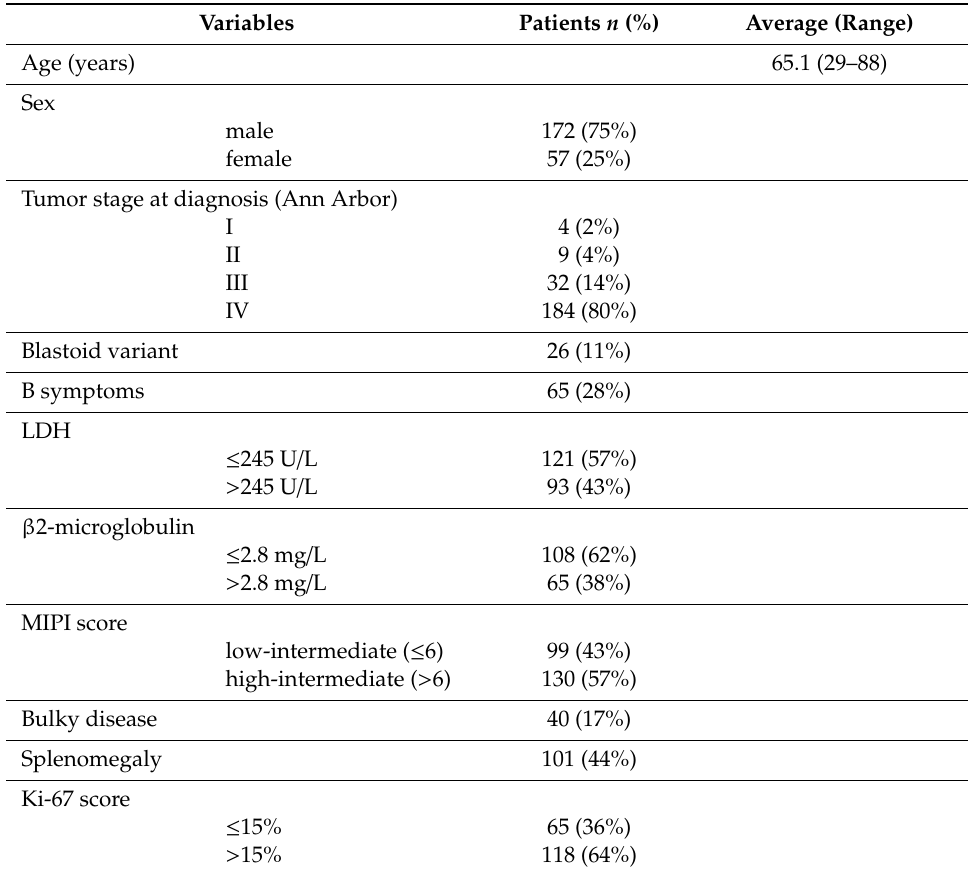
Table 1. Baseline features of our population.